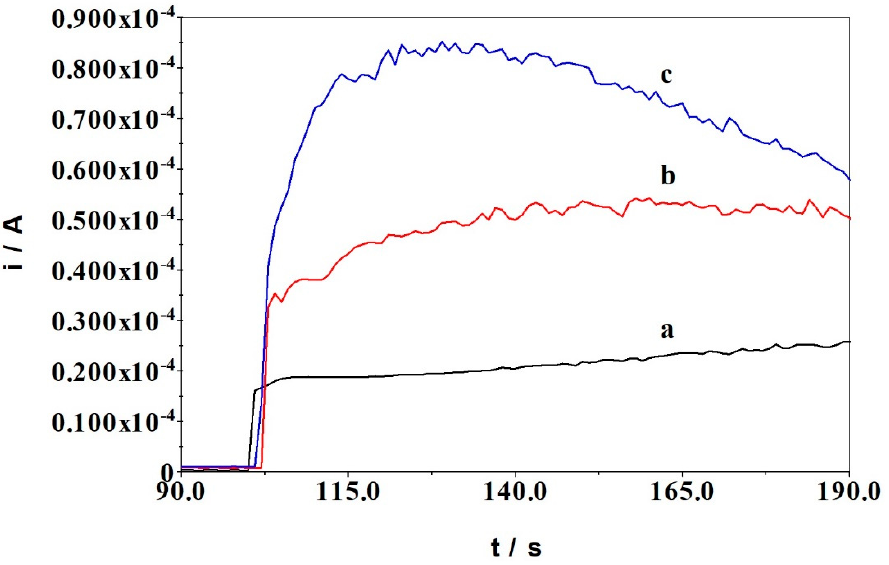
Figure 5. Amperometric response for 1 mM cholesterol added in the mixture (chloroform-TBAP + acetic anhydride) and different content of H 2 SO 4 : 40 μ L ( a ); 100 μ L ( b ) and 200 μ L ( c ).